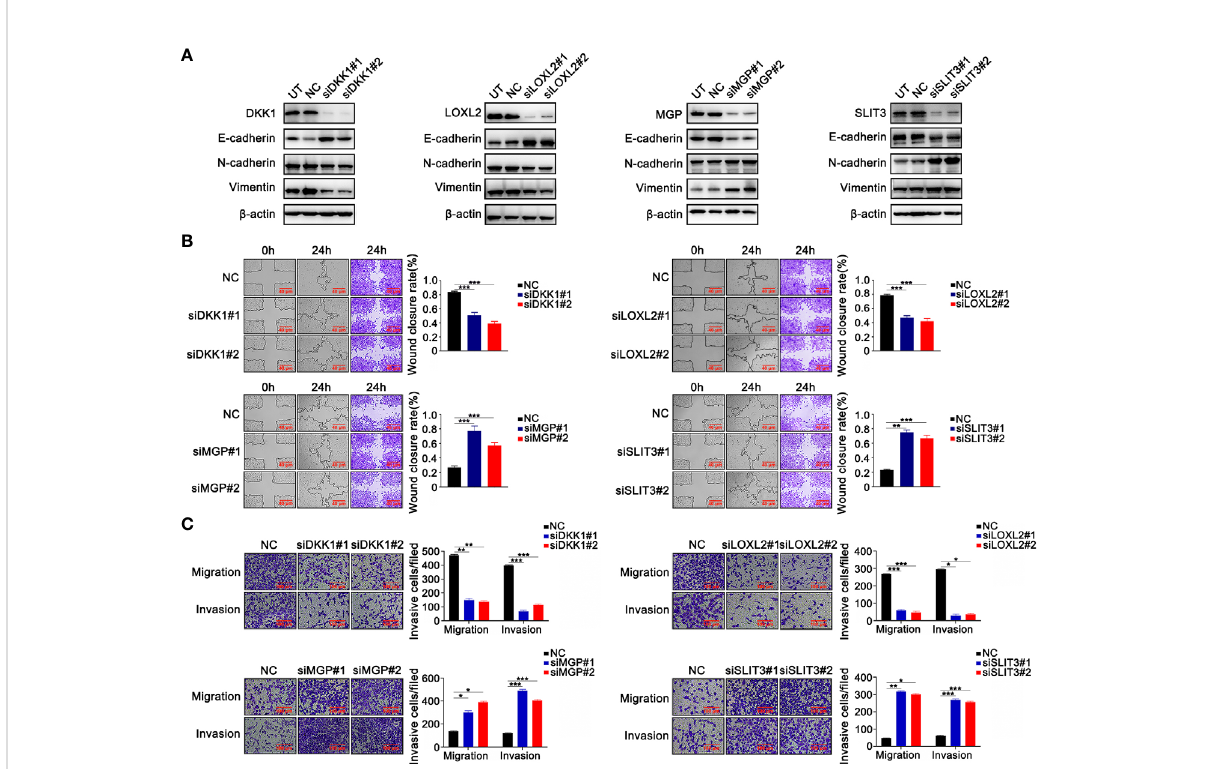
FIGURE 3 The validation experiments of 4 prognostic EMT-related genes comprising the E-signature in vitro . (A) Western blotting con fi rmed that silencing 4 genes respectively caused alterations of EMT ‐ related protein expression in H1299 cells. (B) The effect of silencing four genes on H1299 cell migration con fi rmed by wound-healing assays. (C) Transferability and invasiveness of H1299 cells were evaluated. *P < 0.05; **P < 0.01; ***P < 0.001. Data wereobtained from three independent